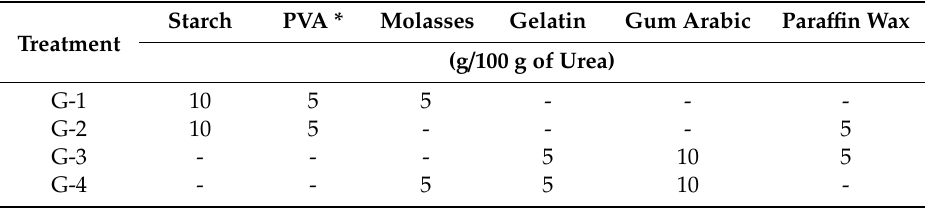
Table 1. Composition of biodegradable polymer coatings of granular